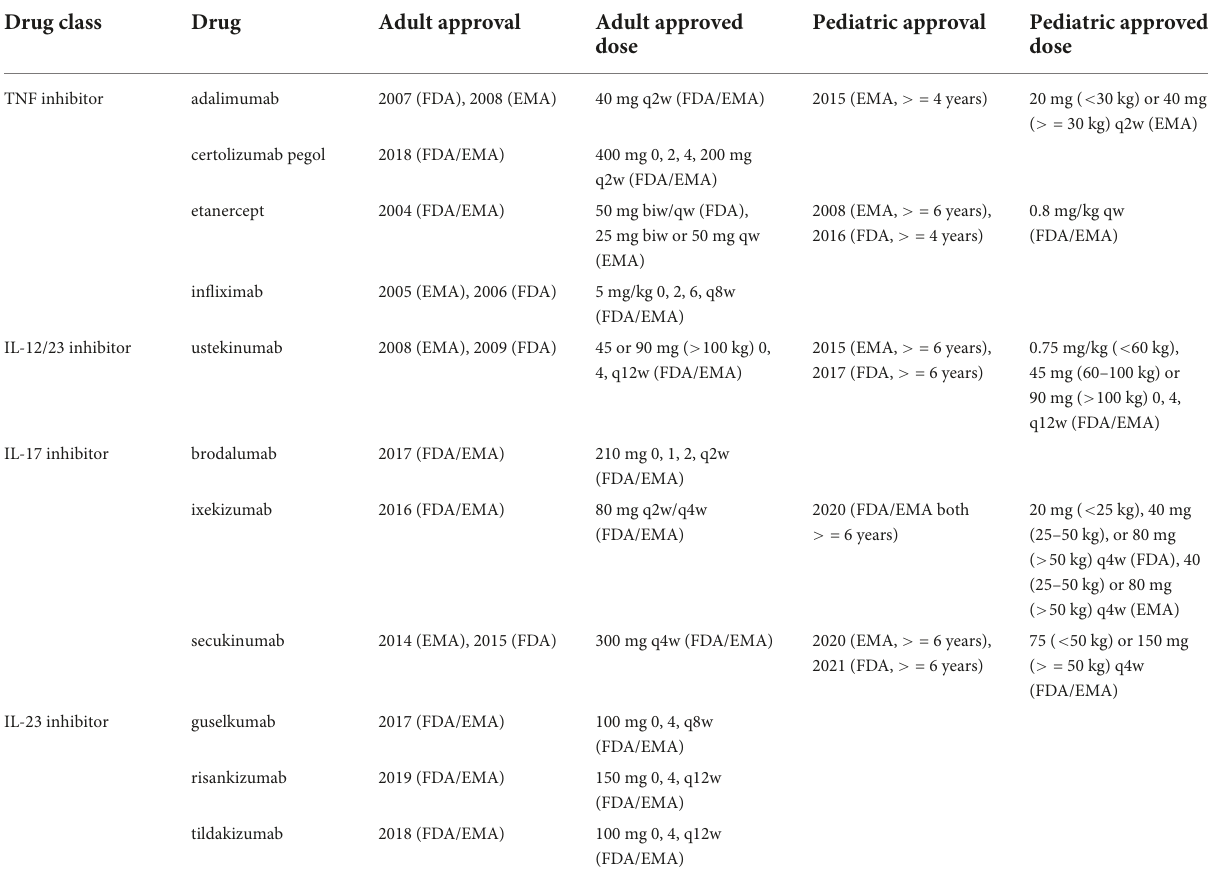
TABLE 5 Overview of approved biologics in adult versus pediatric